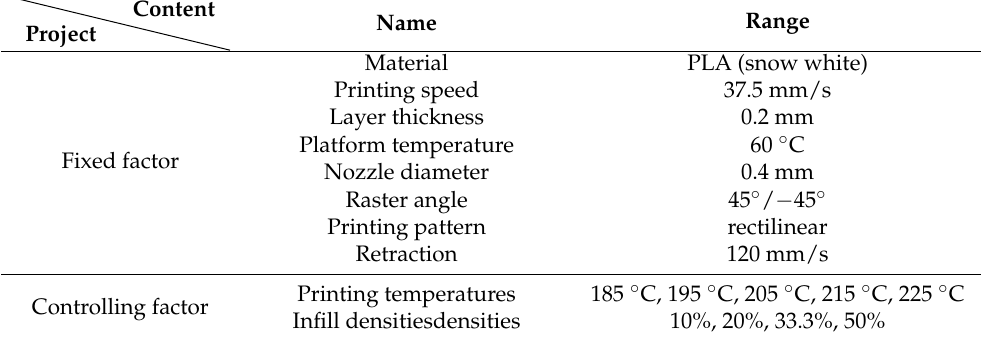
Table 3. Process parameter conditions of the printing material.